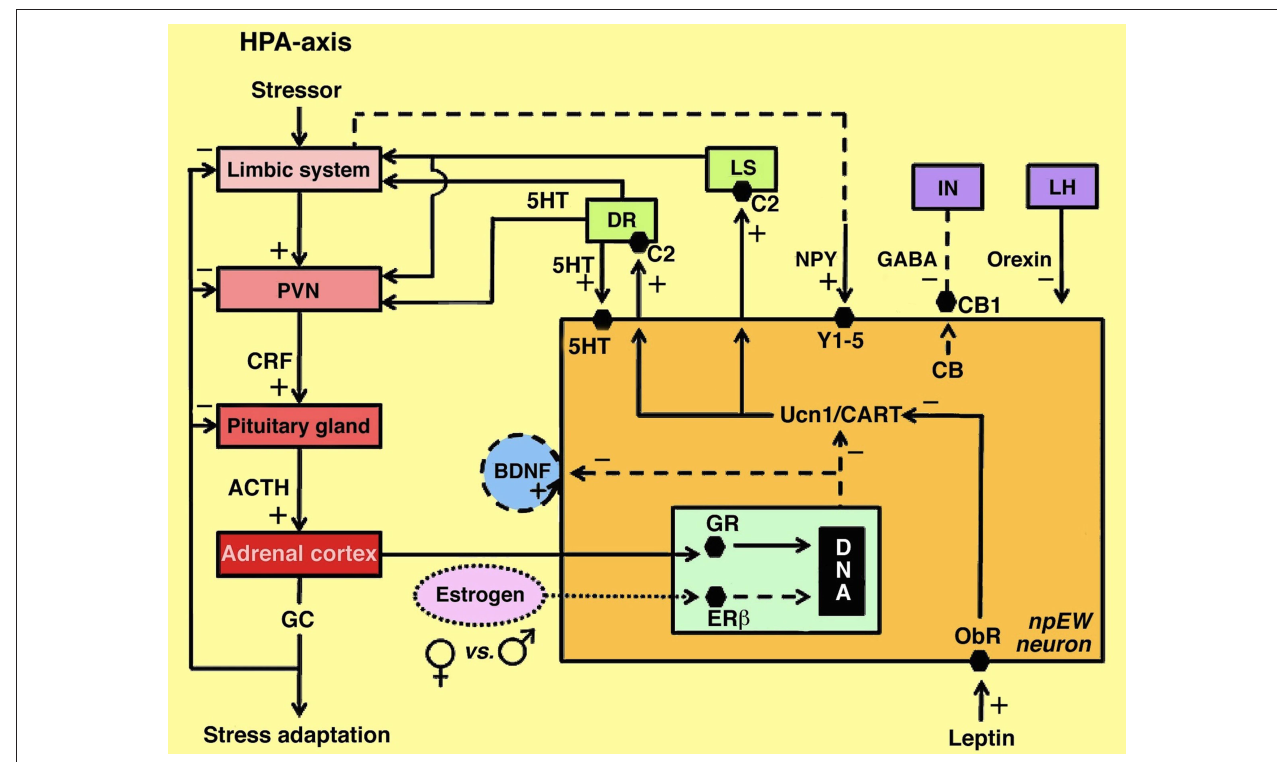
transcript peptide; CB, endocannabinoids; CB1, endocannabinoid receptor 1; CRF, corticotropin-releasing factor; DR, dorsal raphe nucleus; ER β , estrogen receptor β ; GABA, γ -aminobutyric acid; GC, glucocorticoids; GR, glucocorticoid receptor; IN, interneuron; LH, lateral hypothalamus; LS, lateral septum; NPY, neuropeptide Y; ObR, leptin receptor; PVN, paraventricular nucleus; Ucn1, urocortin 1; Y-1/5; neuropeptide Y receptors 1 and 5. (Slightly modified after Derks,